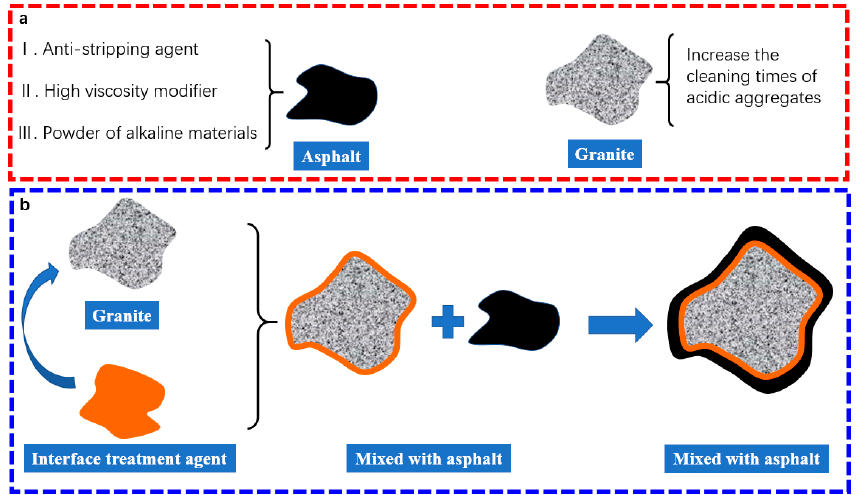
Figure 1. Two main methods to improve the adhesion between asphalt and aggregate: ( a ) Use modified asphalt or clean aggregate, ( b ) Modification of aggregate surface.